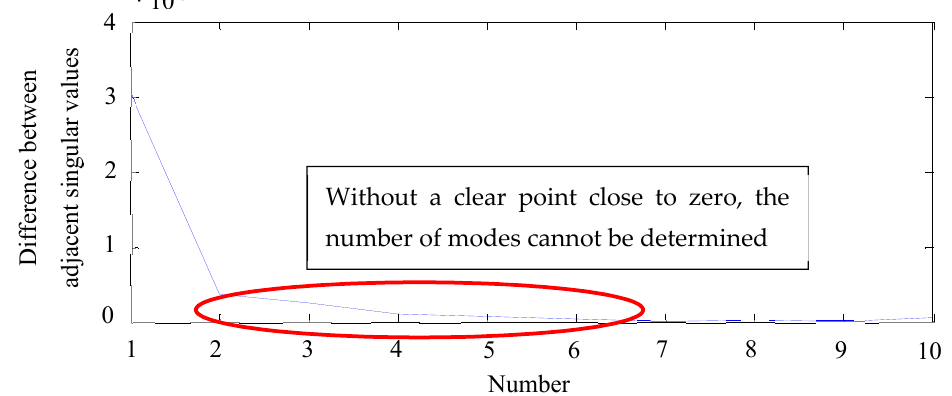
Figure 13. A line graph of adjacent singular value differences obtained by the EWT-SVD method.